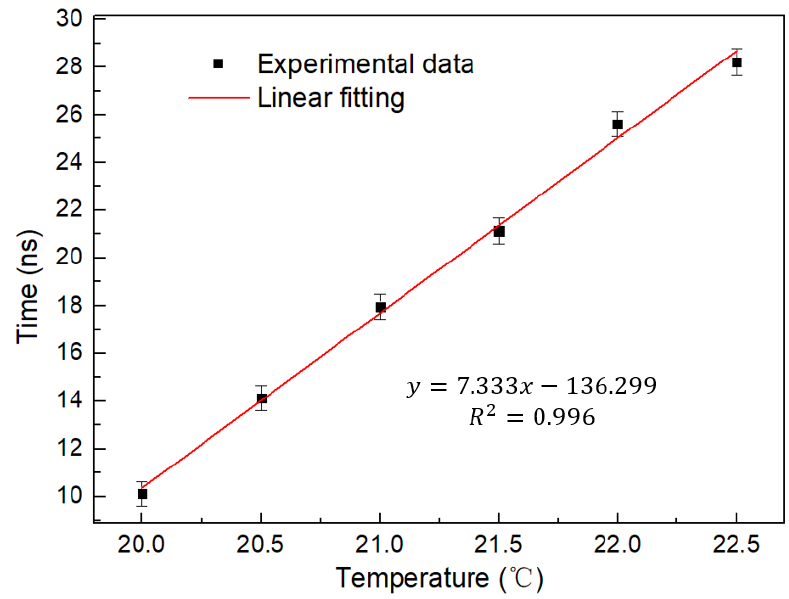
Figure 13. Linear fitting curve of temporal waveform and temperature of cascaded Saganc rings at 20–22.5 °C .